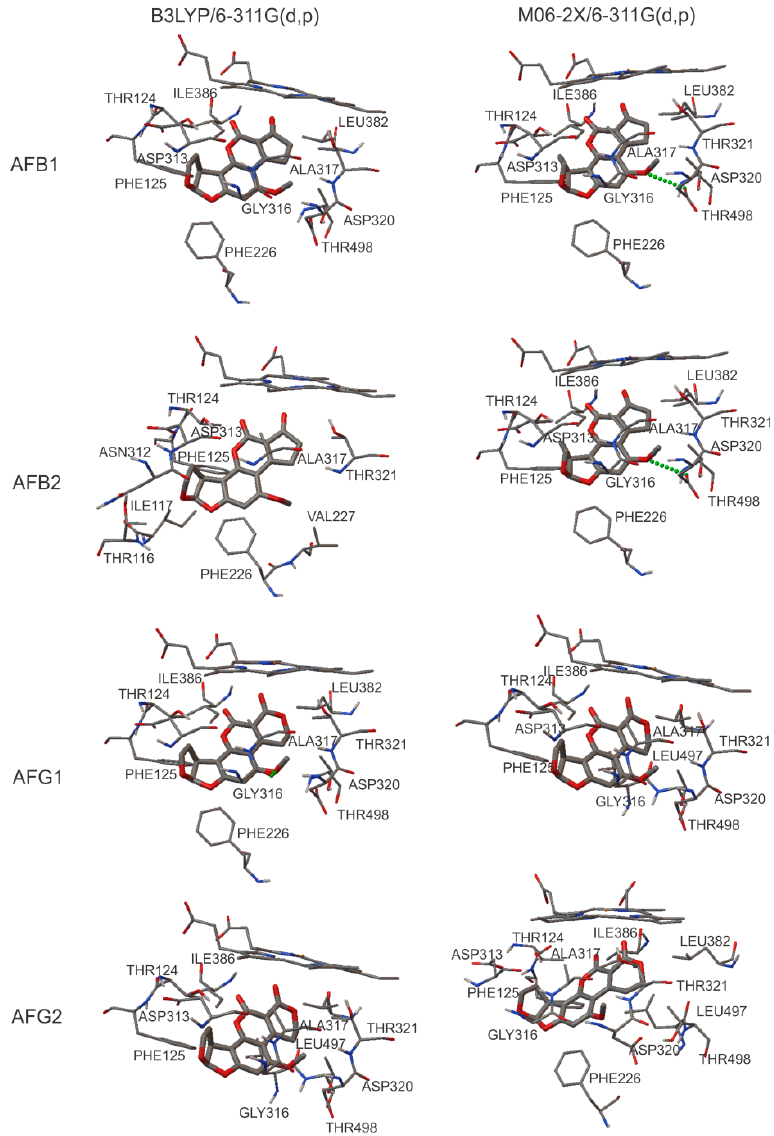
Figure 4. Analysis of the molecular interactions in the active site of CYP1A2 (2HI4 PDB ID) with ligands AFB1, AFB2, AFG1, and AFG2. Hydrogen bonds are indicated with green dotted lines.